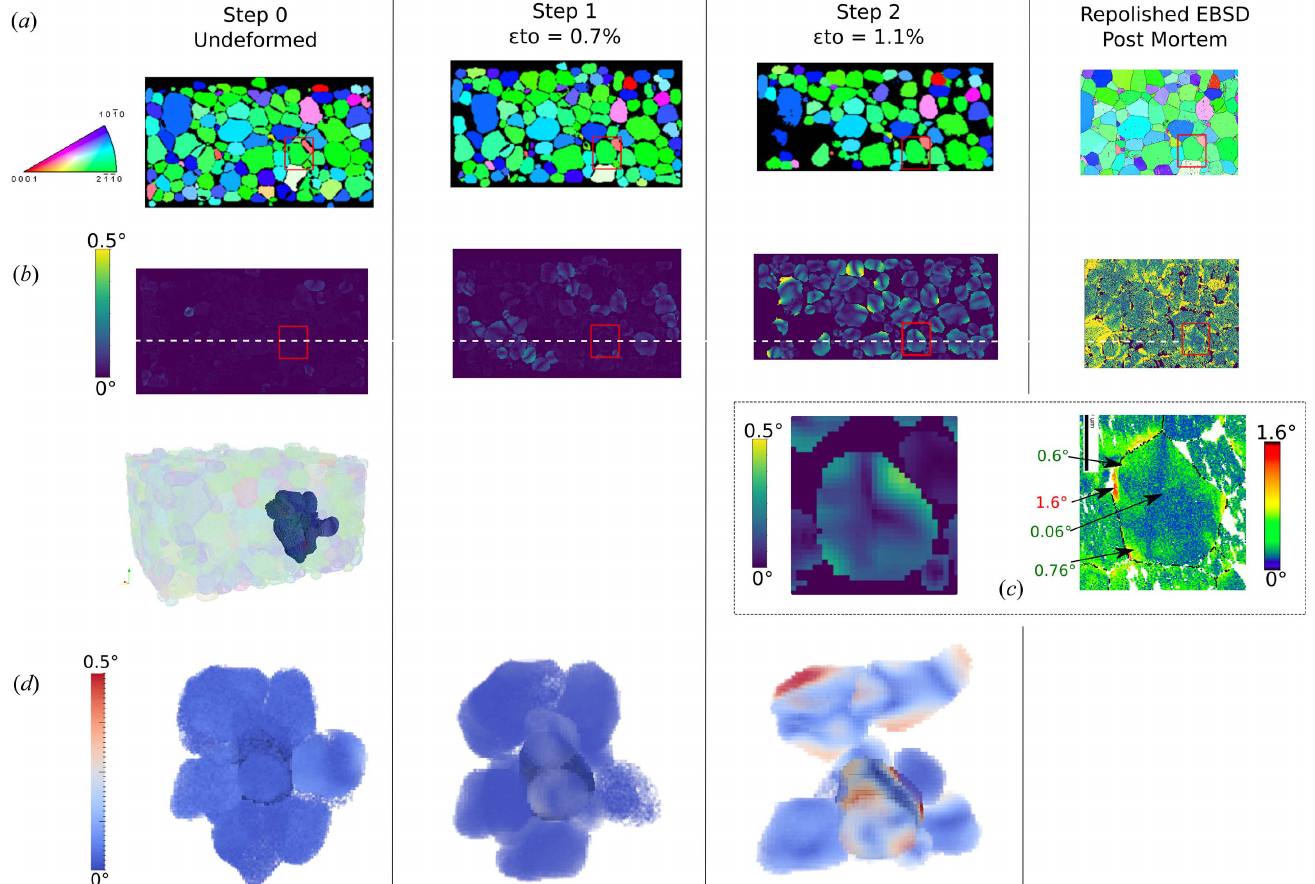
Figure 7 Study and validation of the GROD field from DCT. ( a ) IPF-Z DCT slices and corresponding repolished EBSD face, ( b ) GROD field slices evolution with load, ( c ) quantitative comparison between DCT and EBSD fields in the final deformation state, ( d ) 3D Paraview visualization of GROD field evolution for a grain and its